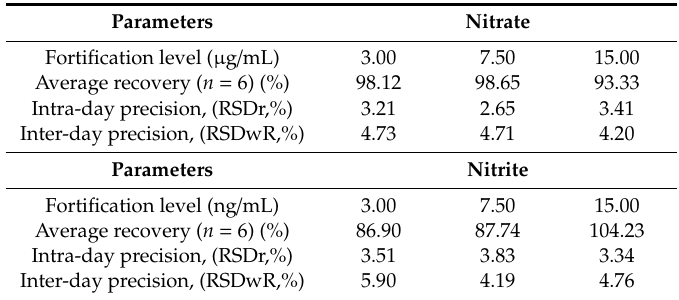
Table 2. Recovery results. RSD: relative standard